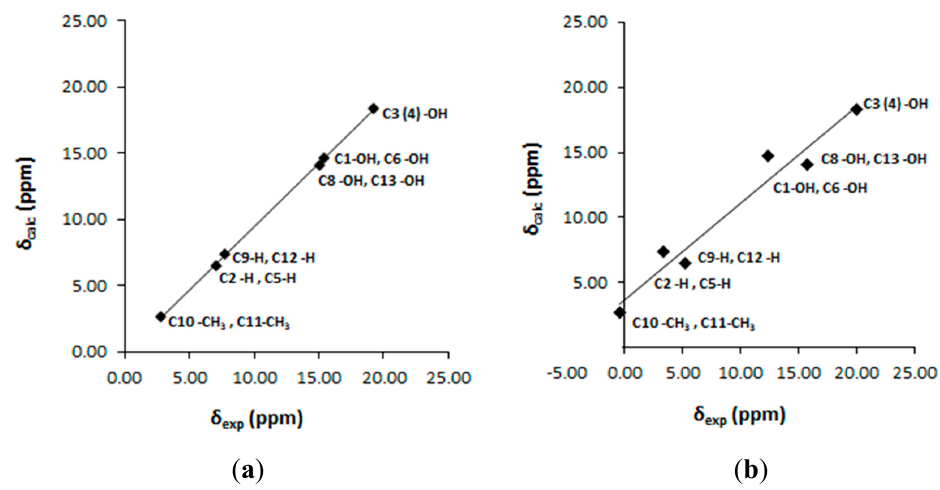
Figure 22. Calculated ( δ calc ) (at the GIAO DFT B3LYP/6-31 +G(2d,p) level of theory) vs. experimental values ( δ exp ) of the 1 H-NMR chemical shifts of hypericinate with minimization of the structure at the TPSSh/TZVP (IEF-PCM) level of theory, ( a ) and with the use of the X-ray structure [78] as input geometry, ( b ) Reprinted, with permission, from [50]. Copyright 2016, by Elsevier Science Ltd.